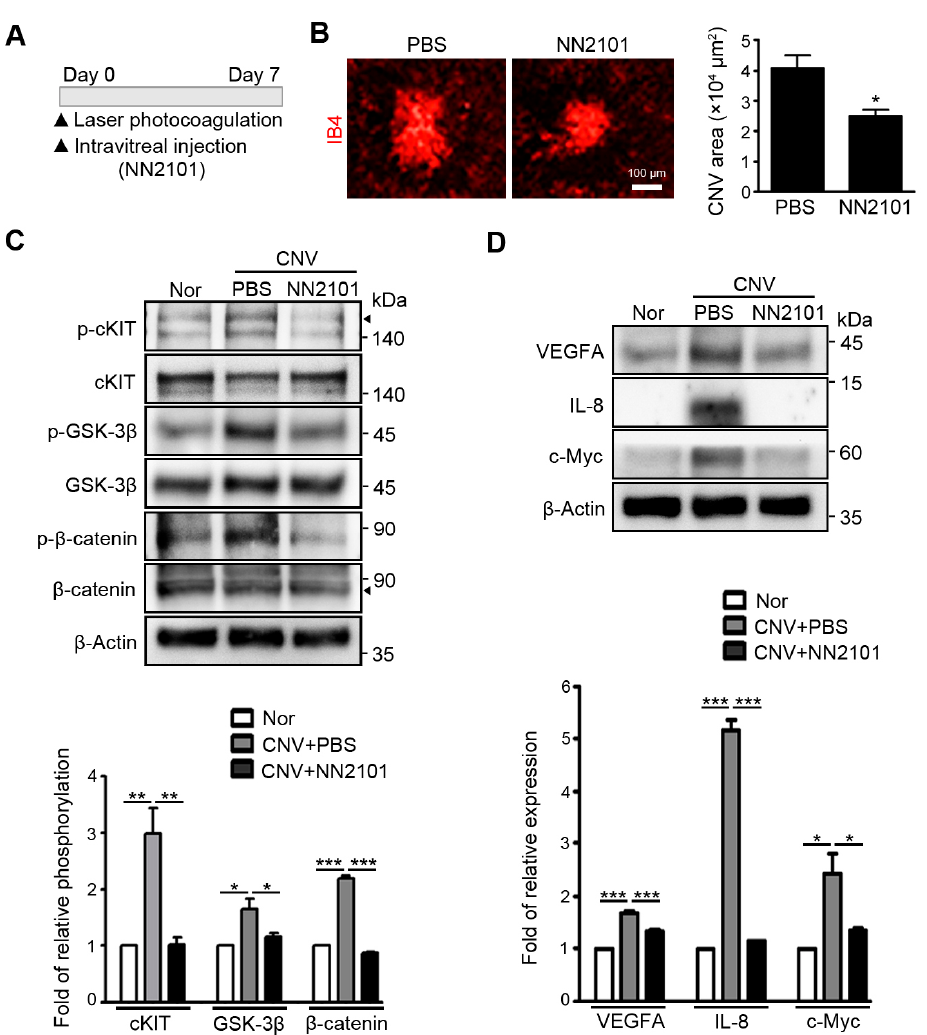
Figure 2. Intravitreal administration of NN2101 suppresses SCF/cKIT signaling and the pathological CNV in murine model of neovascular AMD. ( A ) schematic diagram of laser-induced CNV experiments. Immediately after laser-induced rupture of Bruch’s membrane, mice received an intravitreal injection of NN2101 (1 µ g in 1 µ L) or an equivalent volume of PBS vehicle. On day 7 after laser photocoagulation, choroidal tissues were harvested for further analysis; ( B ) representative images of flat-mounted choroids with CNV lesions and quantification of CNV lesion area. Choroidal flat mounts were stained with IB4 (red) and the relative CNV area was quantified by measuring the fluorescence intensity of images with IB4-positive areas (unpaired Student’s t -test, * p < 0.05, n > 34 laser spots, n > 12 mice per group). Scale bar = 100 µ m. ( C ) The phosphorylation of cKIT (p-cKIT; arrowhead), GSK-3 β (p-GSK-3 β ; Ser9), and β -catenin (p- β -catenin; Ser33/37/Thr41) and ( D ) the protein levels of β -catenin target genes (VEGFA, IL-8, and c-Myc) were assessed using Western blotting and are expressed as the fold increase ± SEM compared to those in the normal (Nor) control group (one-way ANOVA with Bonferroni post hoc multiple comparison test, * p < 0.05, ** p < 0.01, *** p < 0.001, n = 3). β -Actin was used as a loading control. All data are presented as the mean ±